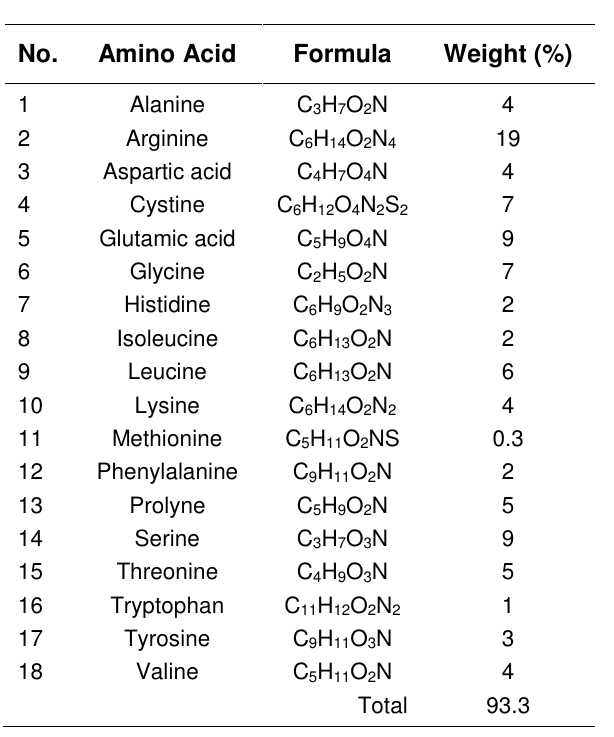
Weight of Amino Acids in